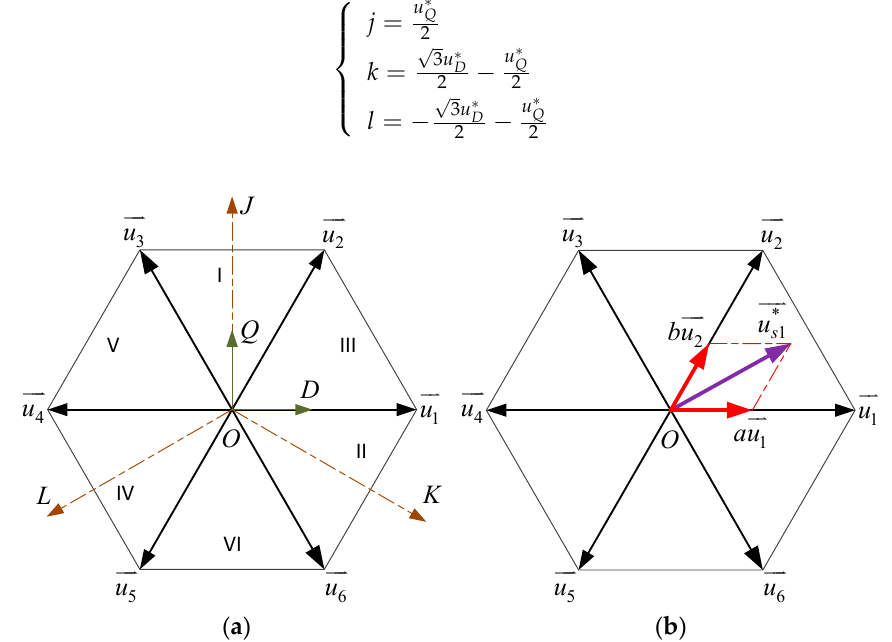
Table 1. Relation table for a, b and N.